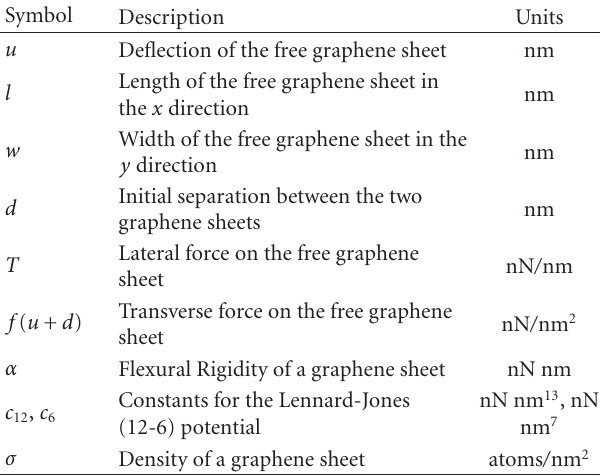
Figure 4: Plot of the transverse force, (4): σ = 38.177 atoms/nm 2 , c = 3 . 859 × 10 − 9 nN nm 13 , and c 12